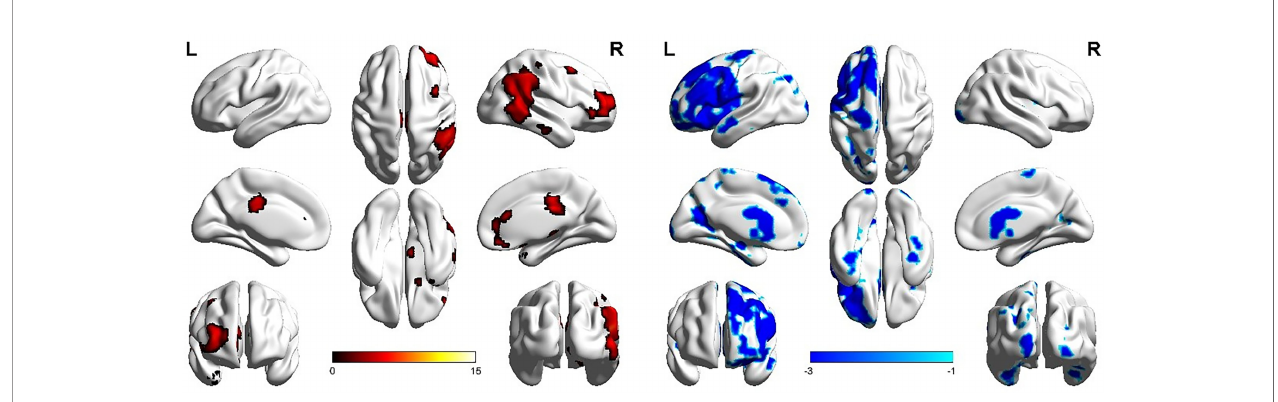
FIGURE 2 | | The abnormal brain regions and functional connectivity found in the left frontoparietal network in ATM and nATM groups. Red indicates the brain region with enhanced functional connectivity in the ATM group, and blue indicates the brain region with the weakened functional connectivity.